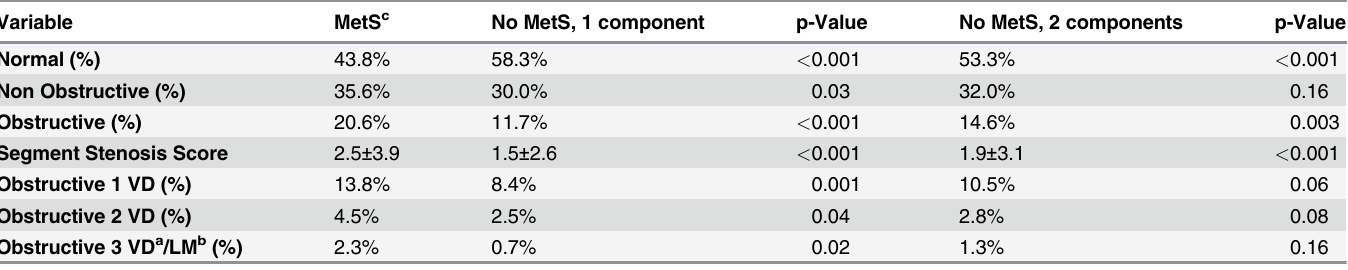
Table 2. Comparison of prevalence, extent and severity of coronary artery disease in matched individuals with versus without MetS based on number of individual components of MetS.